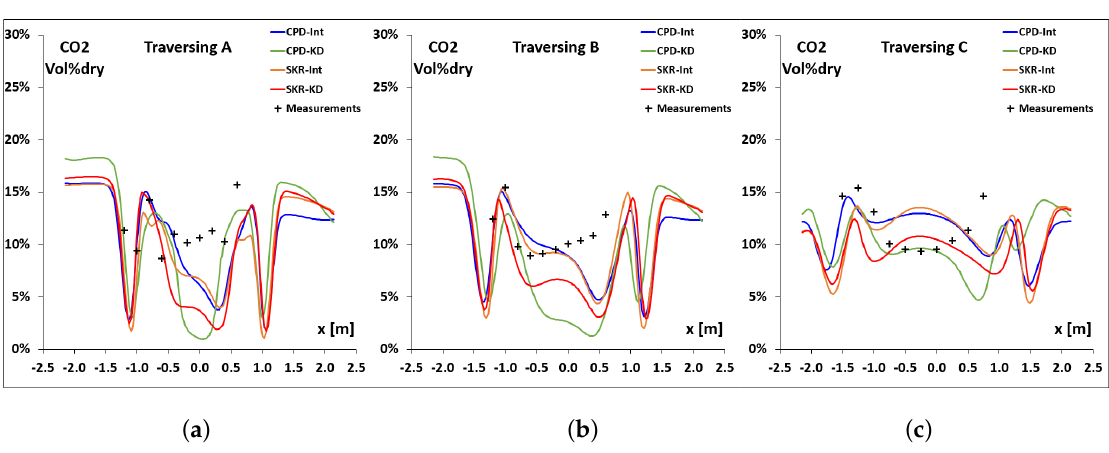
Figure 15. CO 2 molar concentrations distribution along Traverses A ( a ), B ( b ) and C ( c